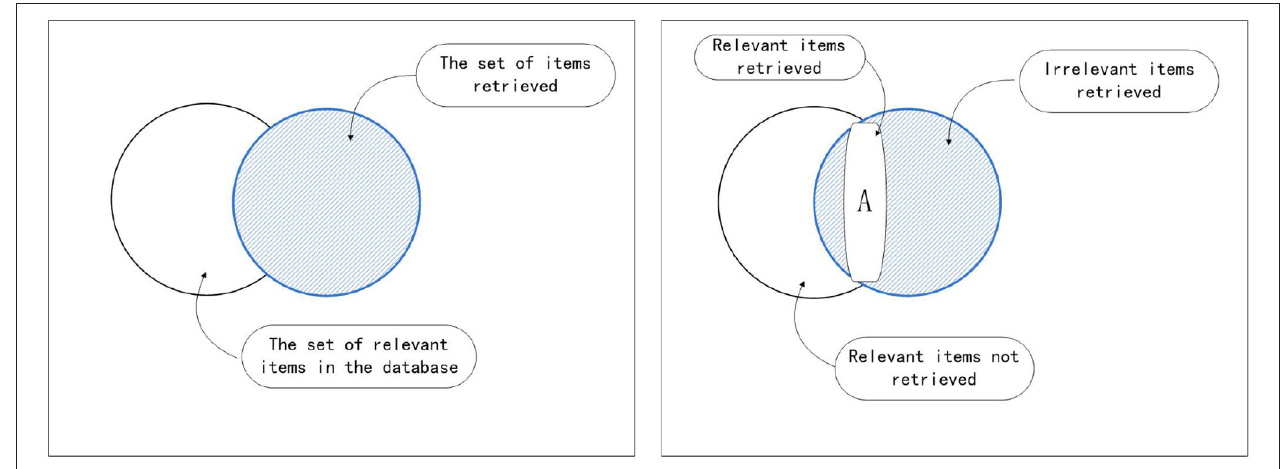
FIGURE 3 | Recognition rate and recall rate explanation.